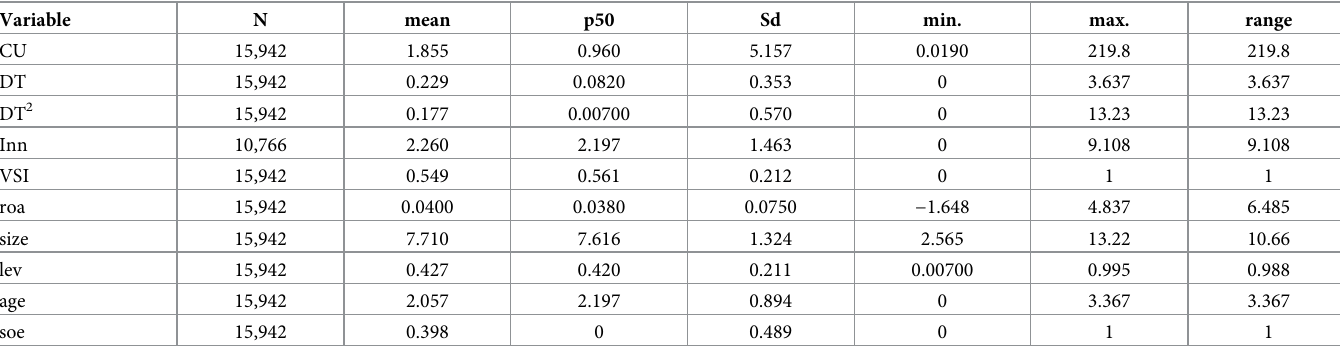
Table 2. Descriptive statistics